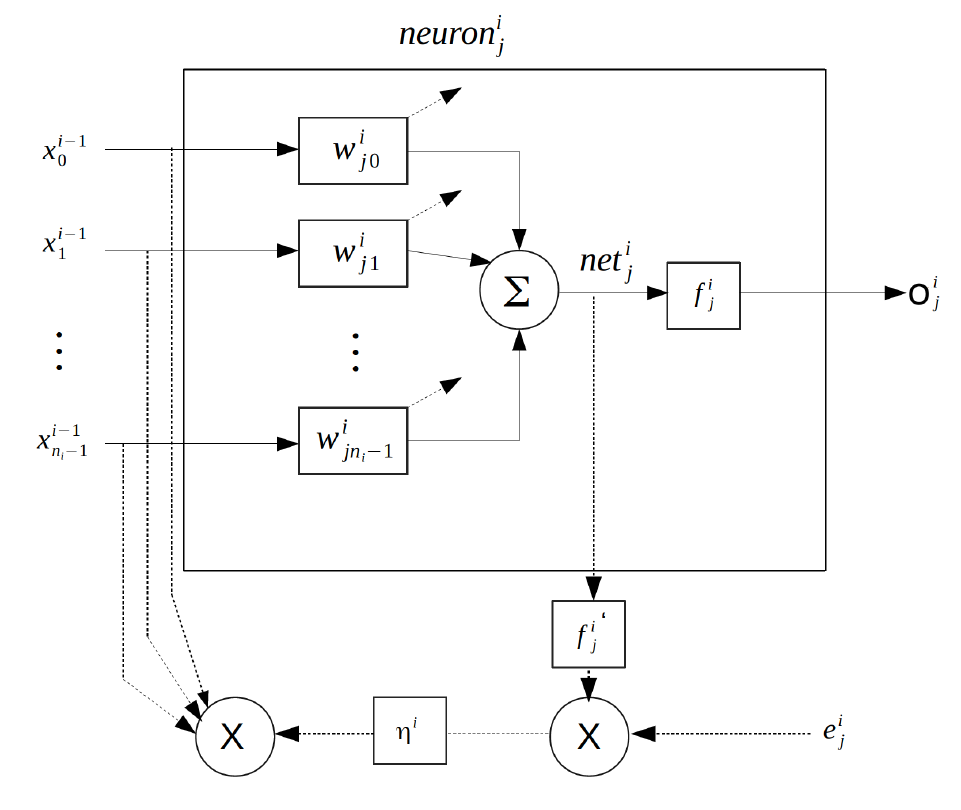
Figure 4. The back-propagation algorithm for the adjustment of neuron